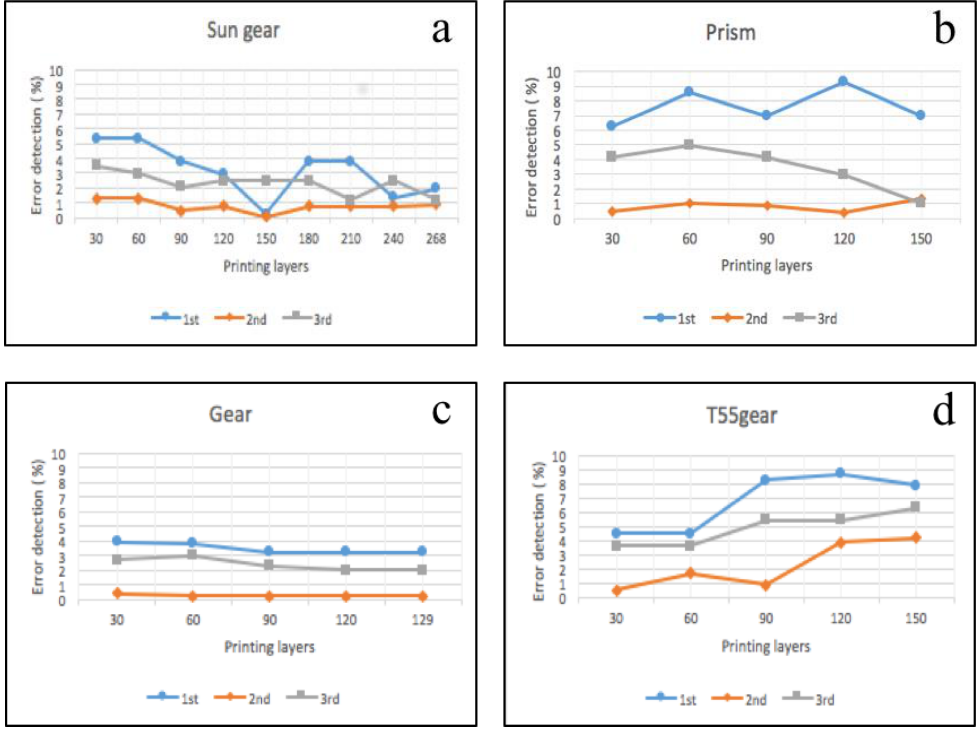
Figure 14. Image pre-processing—Non-rescale and rectification: the error detection of normal printing state for ( a ) sun gear; ( b ) Prism; ( c ) gear; and ( d ) t55gear. J. Manuf. Mater. Process. 2017 , 1 , 2